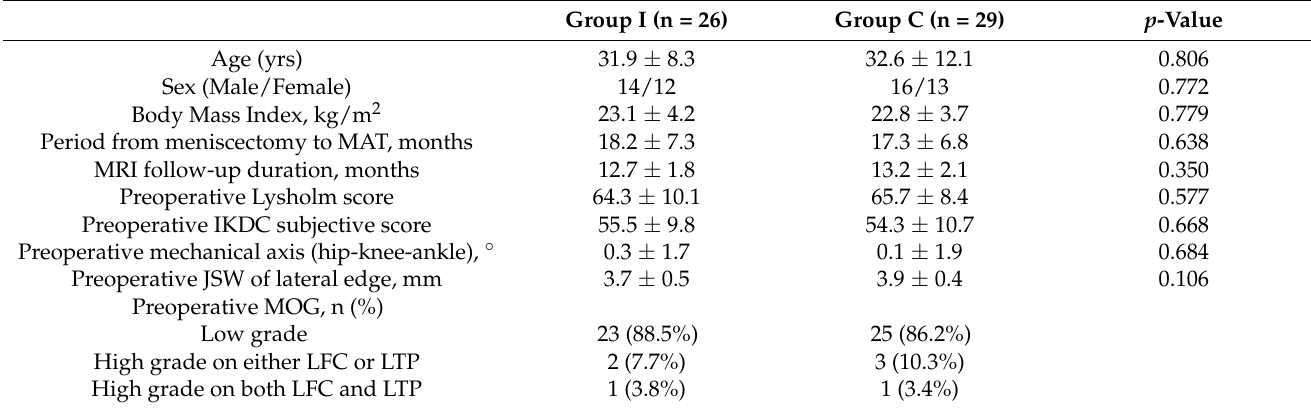
Table 1. Demographic data.